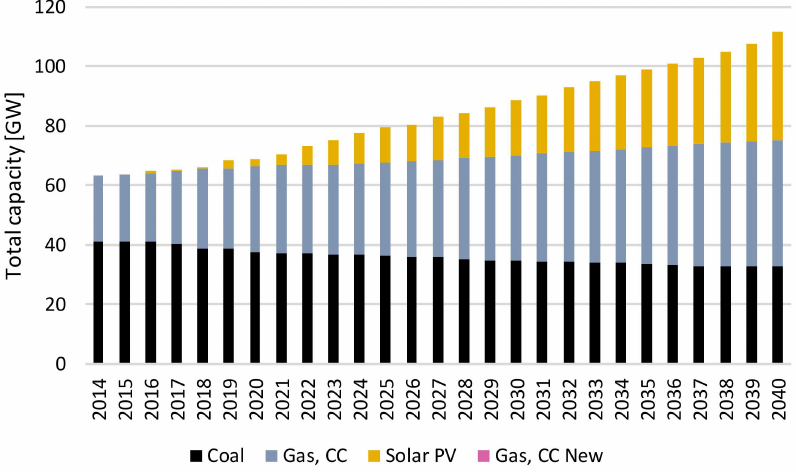
Figure 16. Total capacity (GW) in the REF scenario, in cases of higher gas prices—without code